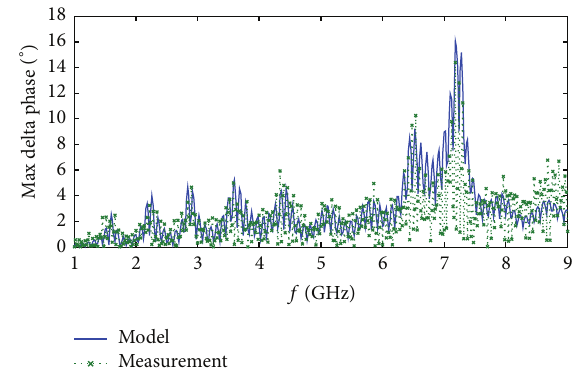
Figure 3: Comparison between the model prediction and the measurement for the maximum phase excursion of 𝑆 11 during a simulated respiratory